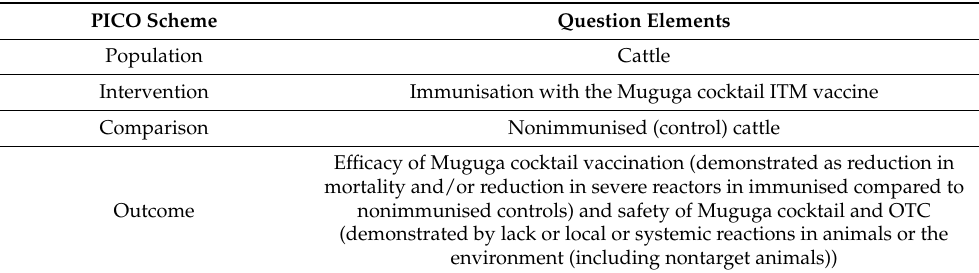
Table 1. Key elements of the research questions as detailed by the PICO